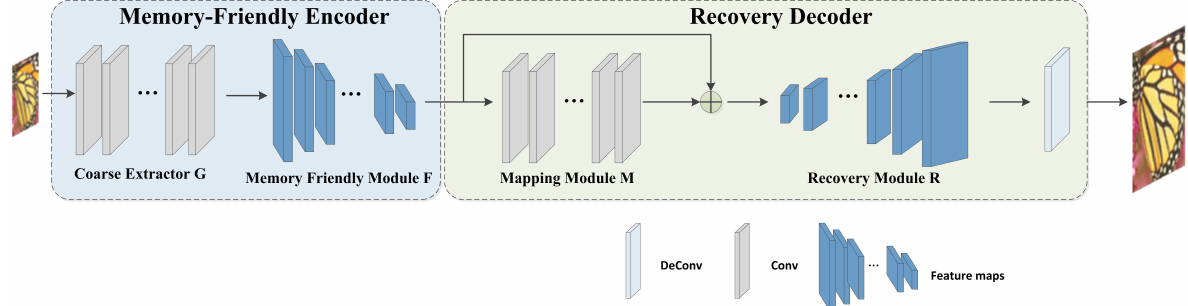
Figure 1. Overall framework of proposed two-stage EMTCM methods. The architecture of EMTCM is composed of two networks, Memory-Friendly Encoder and Recovery